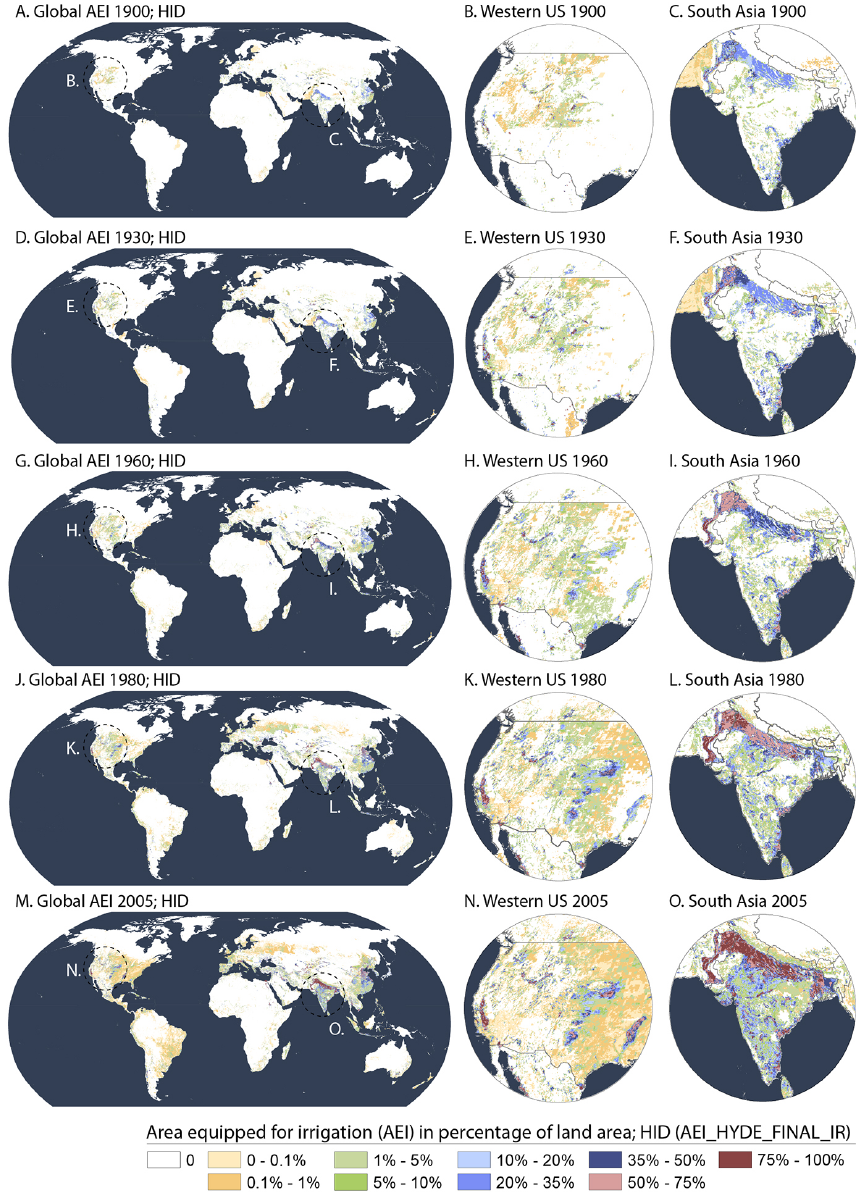
Figure 5. Spatial and temporal evolution of global area equipped for irrigation (AEI) for five time steps (1900, 1930, 1960, 1980, and 2005) based on the product AEI_HYDE_FINAL_IR of the historical irrigation data set (HID). The maps are presented at global scale and for two selected close-up areas, namely western USA and South Asia, for each time